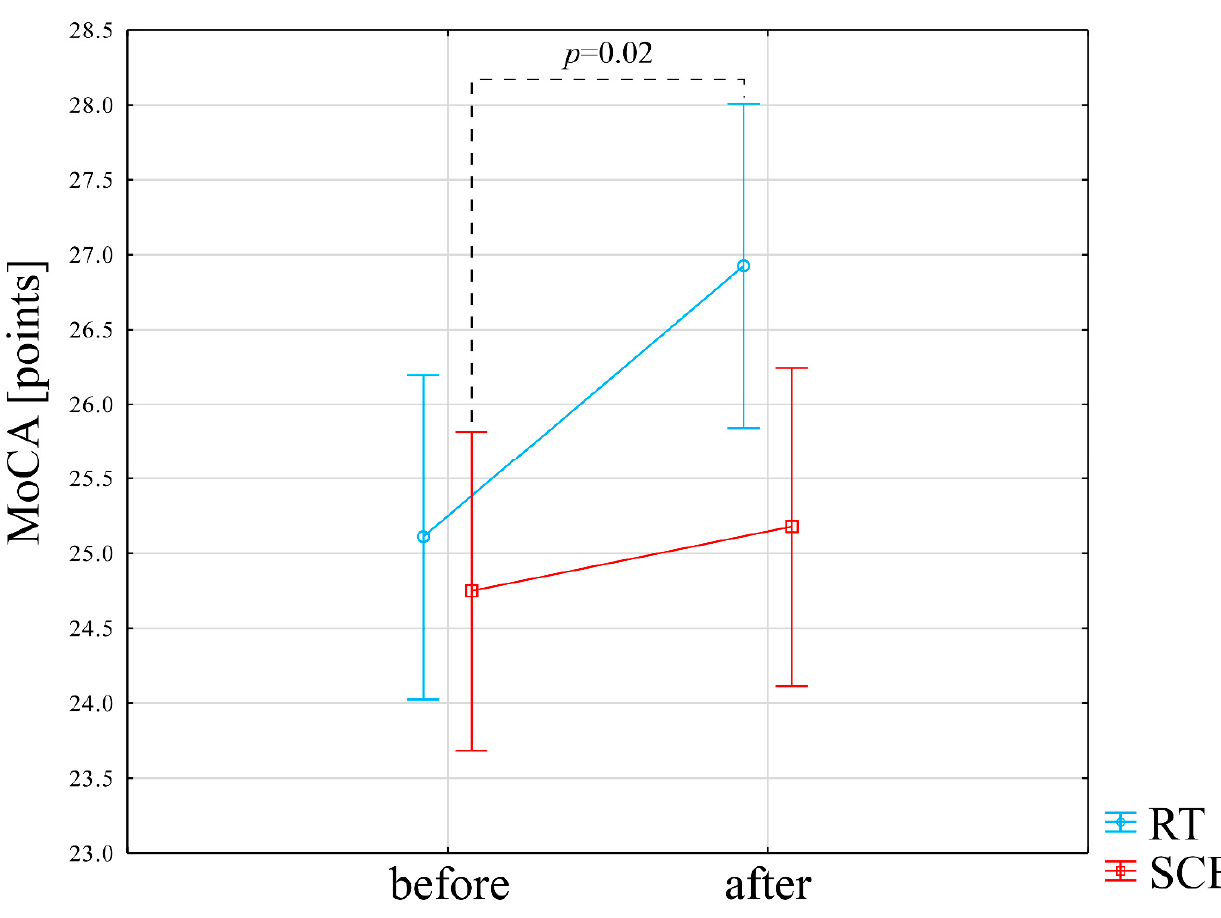
Figure 2. Impact of training programs on the MoCA score. Results from the RT group are denoted by blue lines, while SCB group results are denoted by red lines. Empty circles denote the mean value, vertical bars 95% of the Confidence Interval.